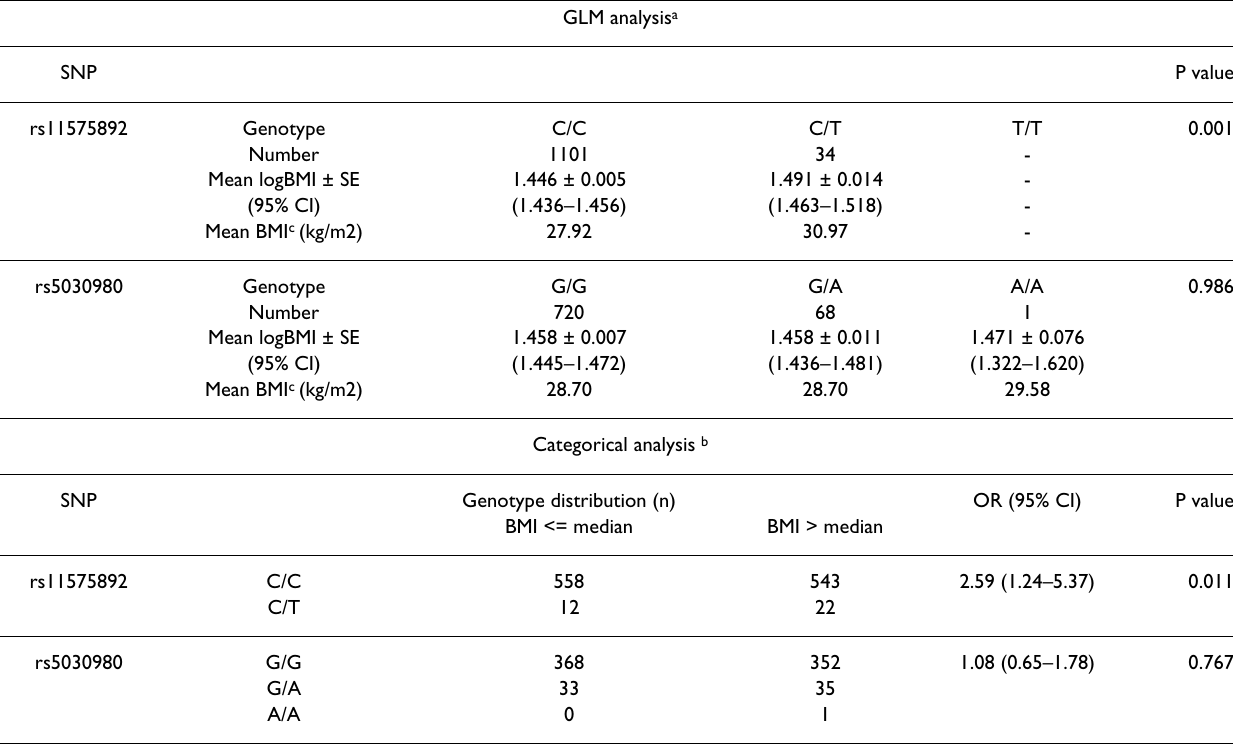
Table 2: Association of BMI with two SNPs